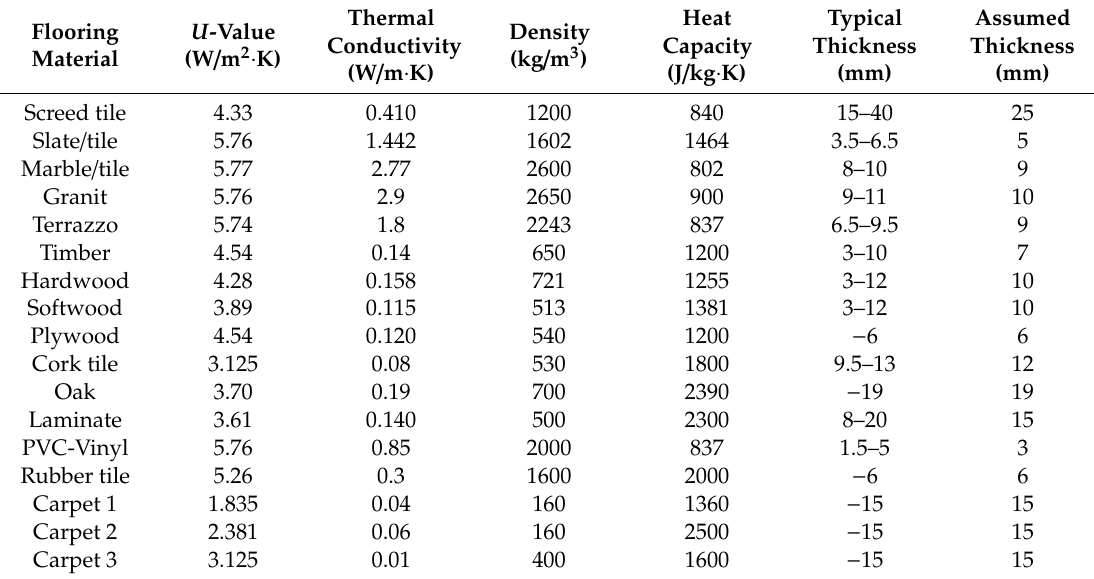
Table 5. Studied flooring material specifications [36].